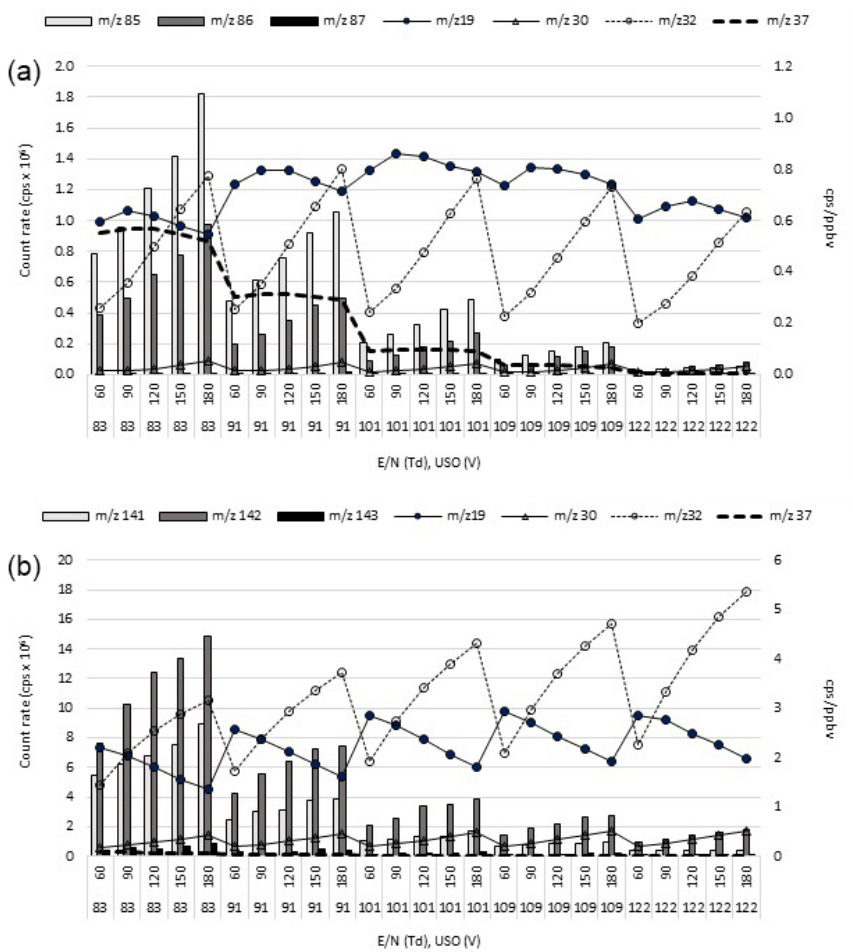
Figure 2. Intensity of signals (counts per second, cps) for H 3 O + ( m/z 19), NO + ( m/z 30), O + sensitivities (cpsppbv − 1 ) at low water flow (2sccm) for (a) n -hexane and (b) n -decane. Data are shown for tests at five E/N ratios (83, 91, 101, 109 and 122Td) and five U SO voltages (60, 90, 120, 150 and